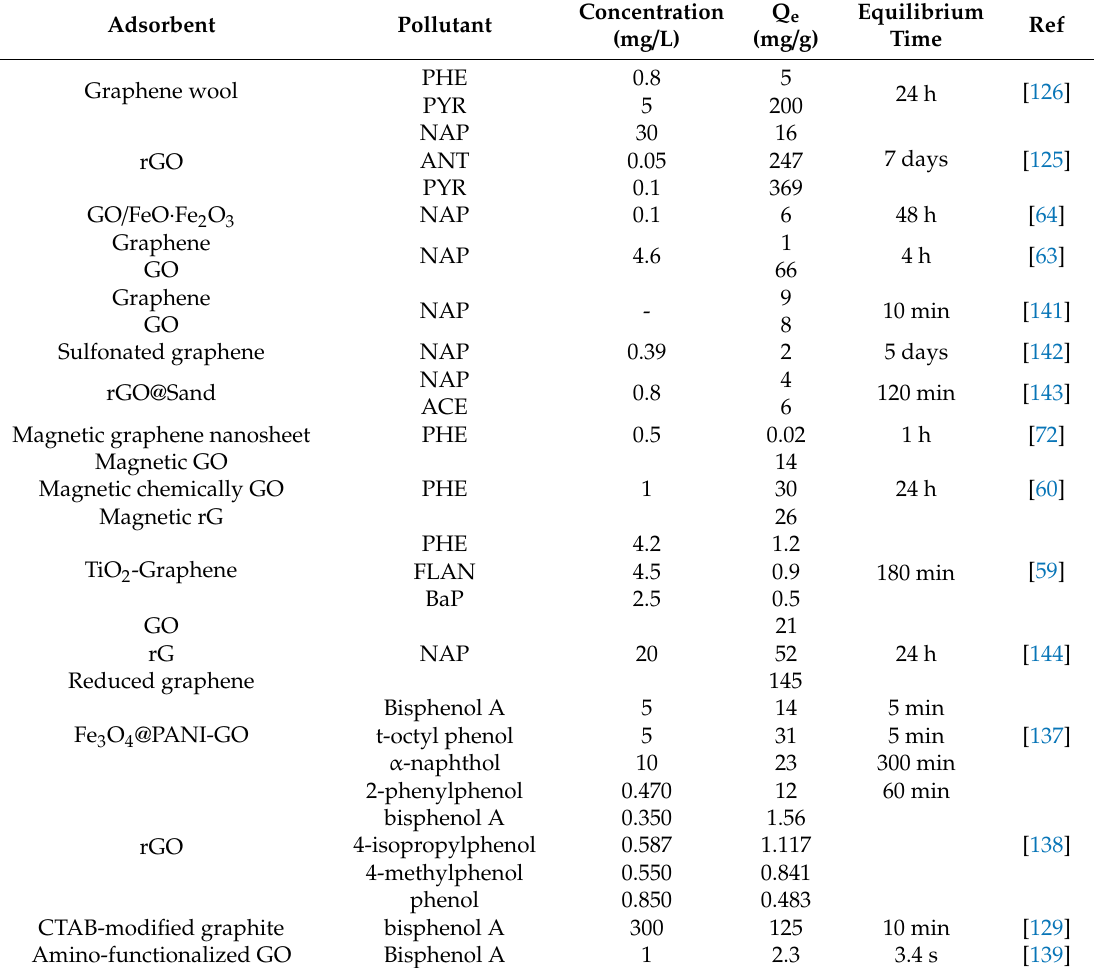
Table 6. Adsorptions of PAHs and phenols onto graphene, GO and reduced graphene oxide (rGO) and their composites.